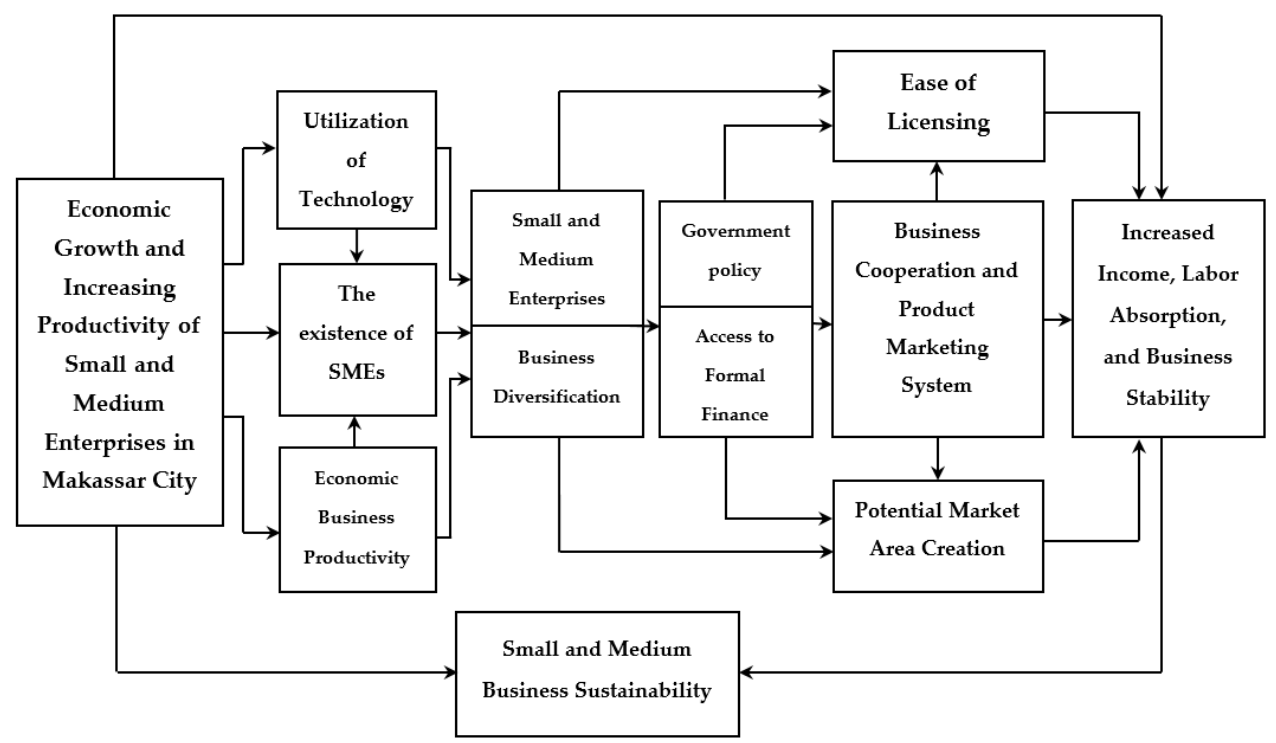
Figure 1. The conceptual framework of economic growth, technological innovation, and community economic business sustainability. Source: author’s elaboration.